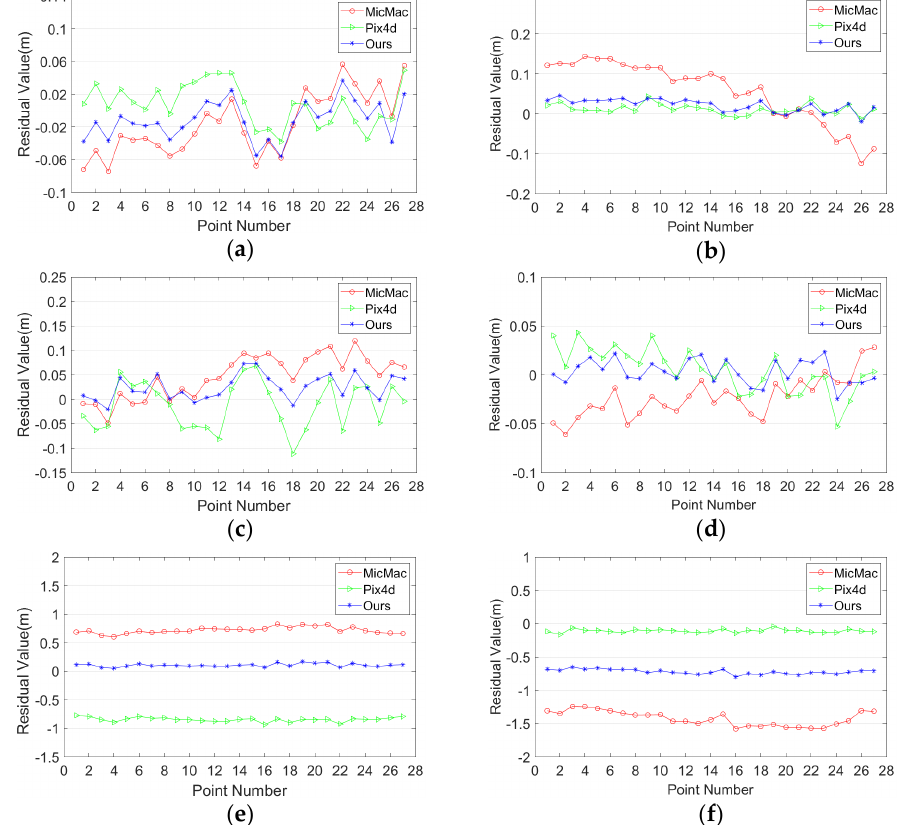
Figure 11. The residuals of check points after self-calibration with different software for test site 2. ( a , c , e ) The residuals of check points of rectangle dataset in the direction of X, Y, and Z, respectively; ( b , d , f ) the residuals of check points of S-shaped dataset in the direction of X, Y, and Z, respectively.